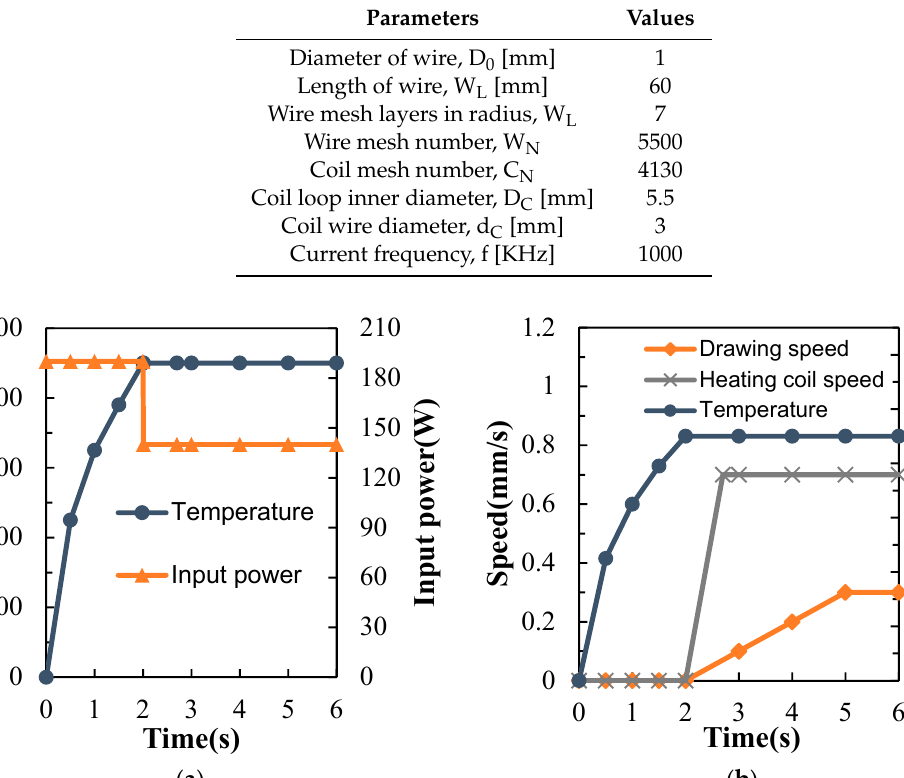
Figure 11. ( a ) Relationships between forming temperature variation and input power, ( b ) Relationships between heating speed, forming temperature and drawing speed.